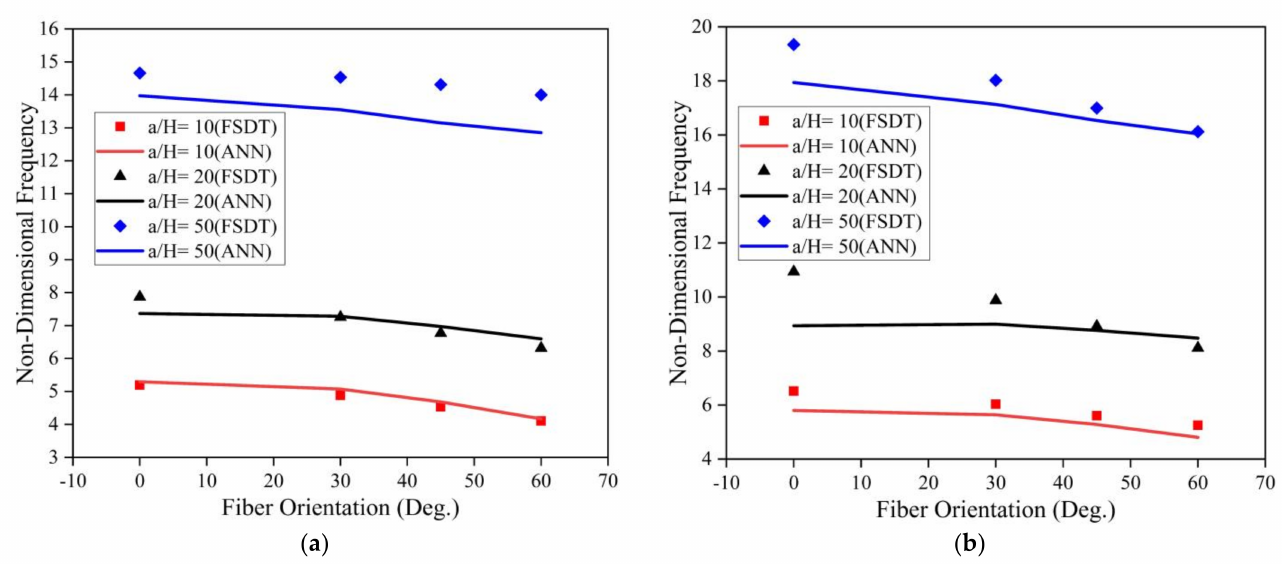
Figure 16. Influence of the face sheet fiber orientation angle on the skew LCS plate in the presence of a moisture environment (0.75 %) for varying a/H ratios operating under ( a ) SSSS and ( b ) CCCC boundary